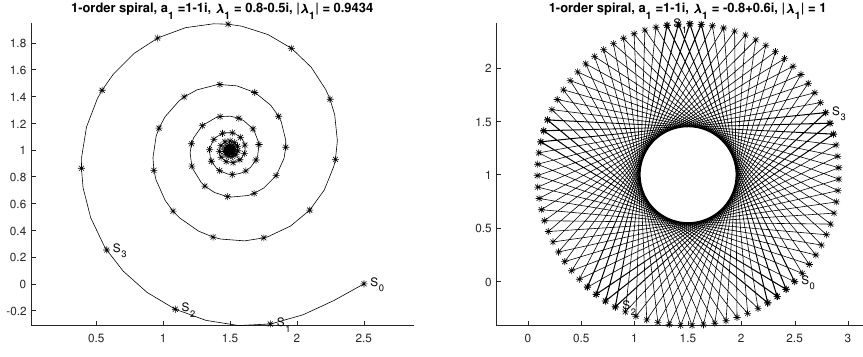
Figure 4. First order spirals with λ 1 = 0.8 − 0.5 i ( left ) and λ 1 = − 0.8 + 0.6 i ( right ).